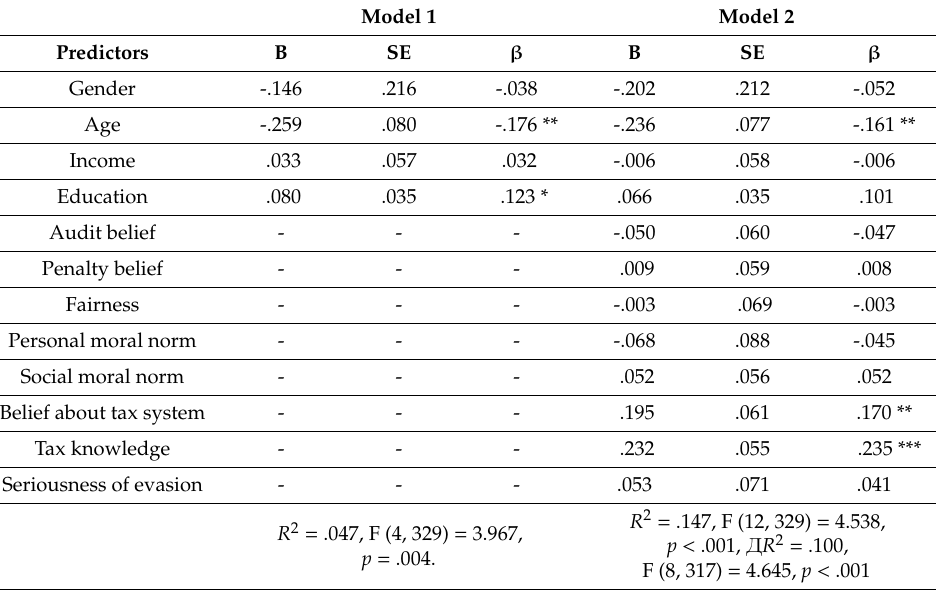
Table 1. Regression analyses for tax planning.